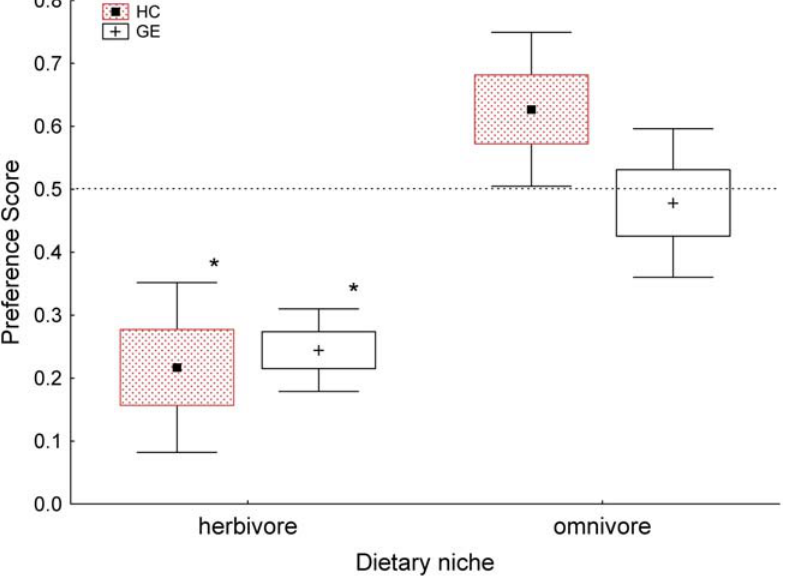
Figure 3. Herbivores, but not omnivores, avoid HC and GE. Herbivores (g. pig, mtnbeaver, gopher, vole, rabbit) differed significantly from omnivores (dmouse, coyote, mouse, rat, wfmouse) in scores for both hydrolysates ( P s=0.001); asterisks indicate significant ( P s , 0.015) differences from 0.5 (which would indicate no discrimination between the hydrolysate and the cellulose diet); boxes=means 6 SE, whiskers=means 6 SD.